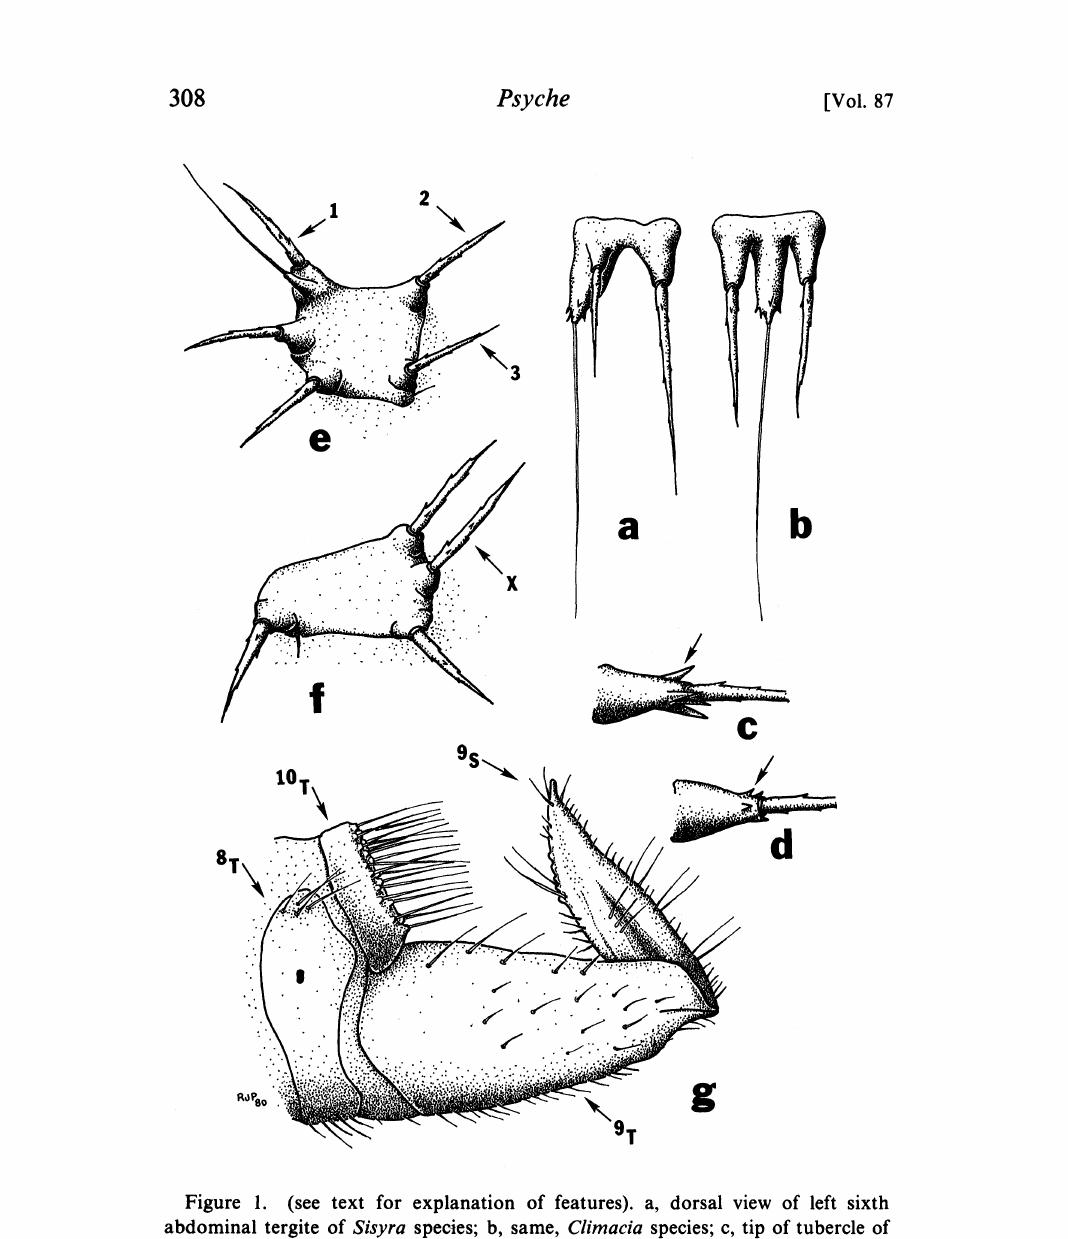
Figure 1. (see text for explanation of features), a, dorsal view of left sixth abdominal tergite of Sisyra species; b, same, Climacia species; c, tip of tubercle of Climacia areolaris; d, same, other Climacia and Sisyra species; e, dorsal view of left prothoracic tergite of Sisyra vicaria, typical of other sisyrid species; f, dorsal view of right mesothoracic or metathoracic tergite of C. californica and Baja Climacia species; g, Climacia striata, lateral view of female